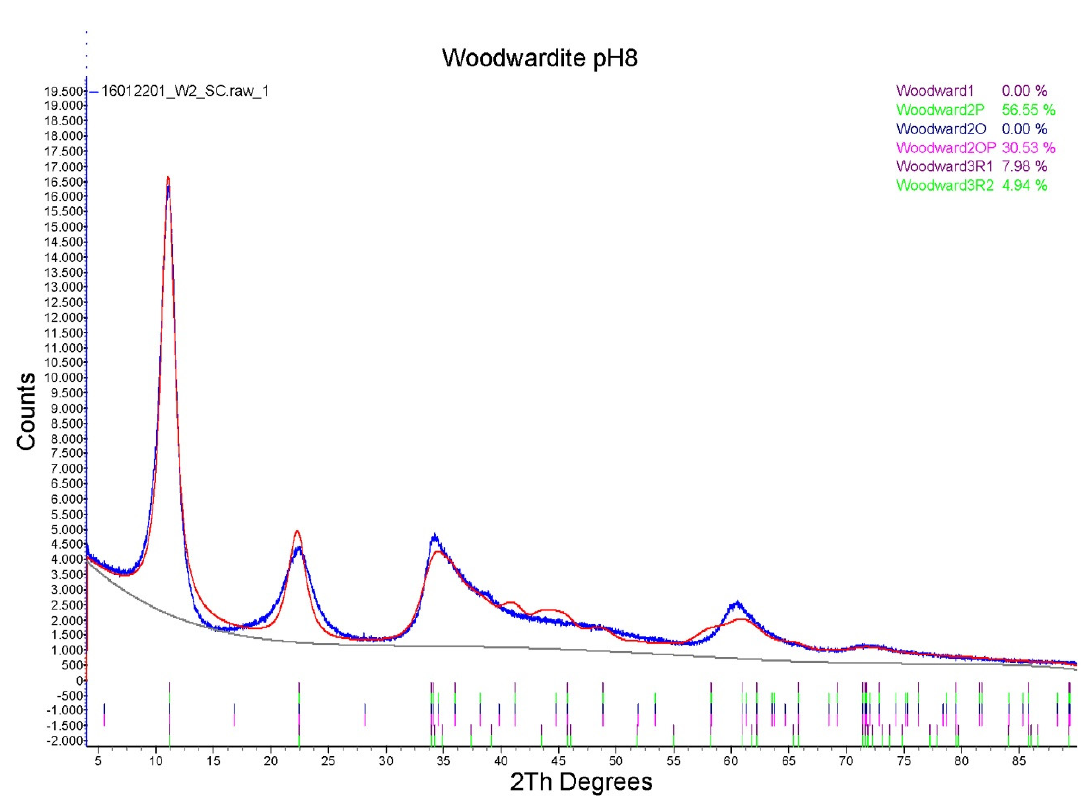
Figure 2. Rietveld refinement results (red line) of the LDH 3CuAl·SO 4 at pH 8 PXRD diagram (blue line) with different polytypes.